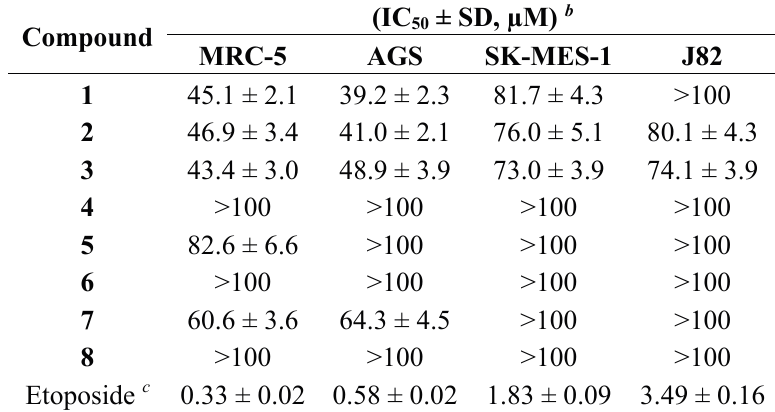
Table 1. Antiproliferative activity of carnosic acid γ -lactone derivatives 1 – 8 against MRC-5 normal fibroblasts and selected tumor cell lines a